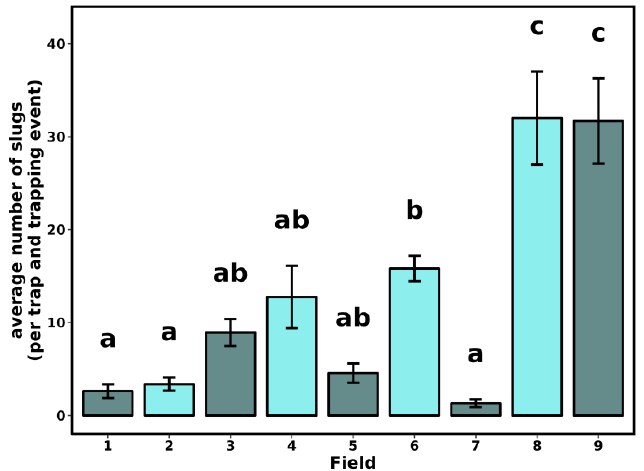
Figure 1. Average number of slugs per trap (4 traps of 1 m 2 ) and per trapping event (4) in each survey field. Details on the field conditions are provided in Table 1. Bars indicate SEM. Letters indicate statistical differences among fields.